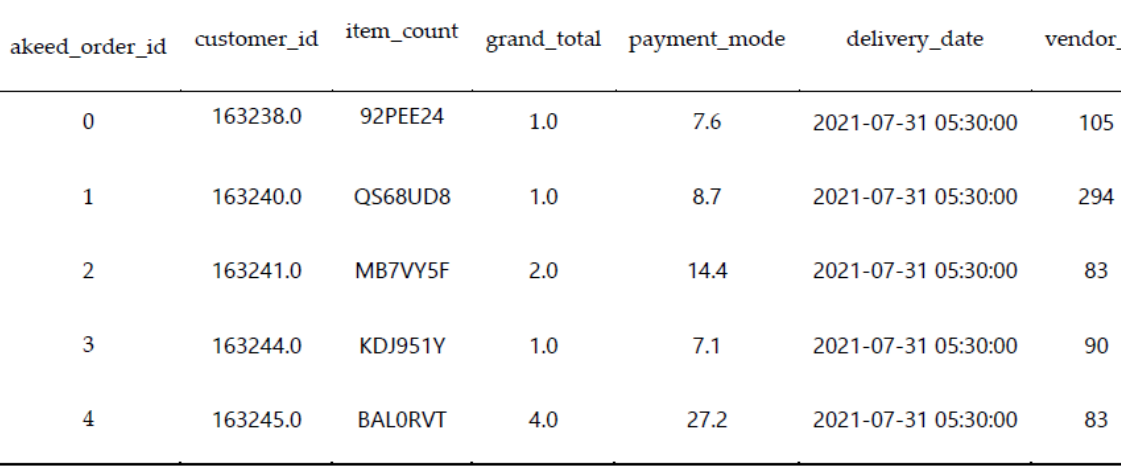
Figure 27. Order dataset class sample data.